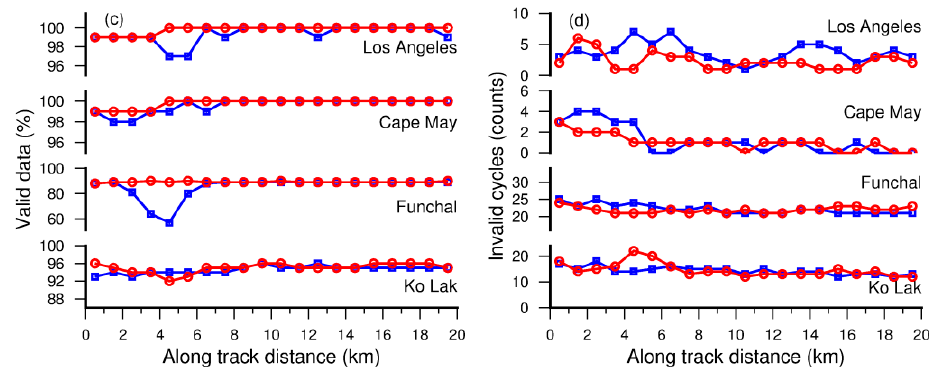
Figure 8. Standard deviation ( a ) correlation coefficient ( b ) valid data percentile ( c ) and invalid cycle number ( d ) of ALES product ( blue ) in the four study regions. For comparison, the results of DW-TR ( red ) are also shown in the figure.